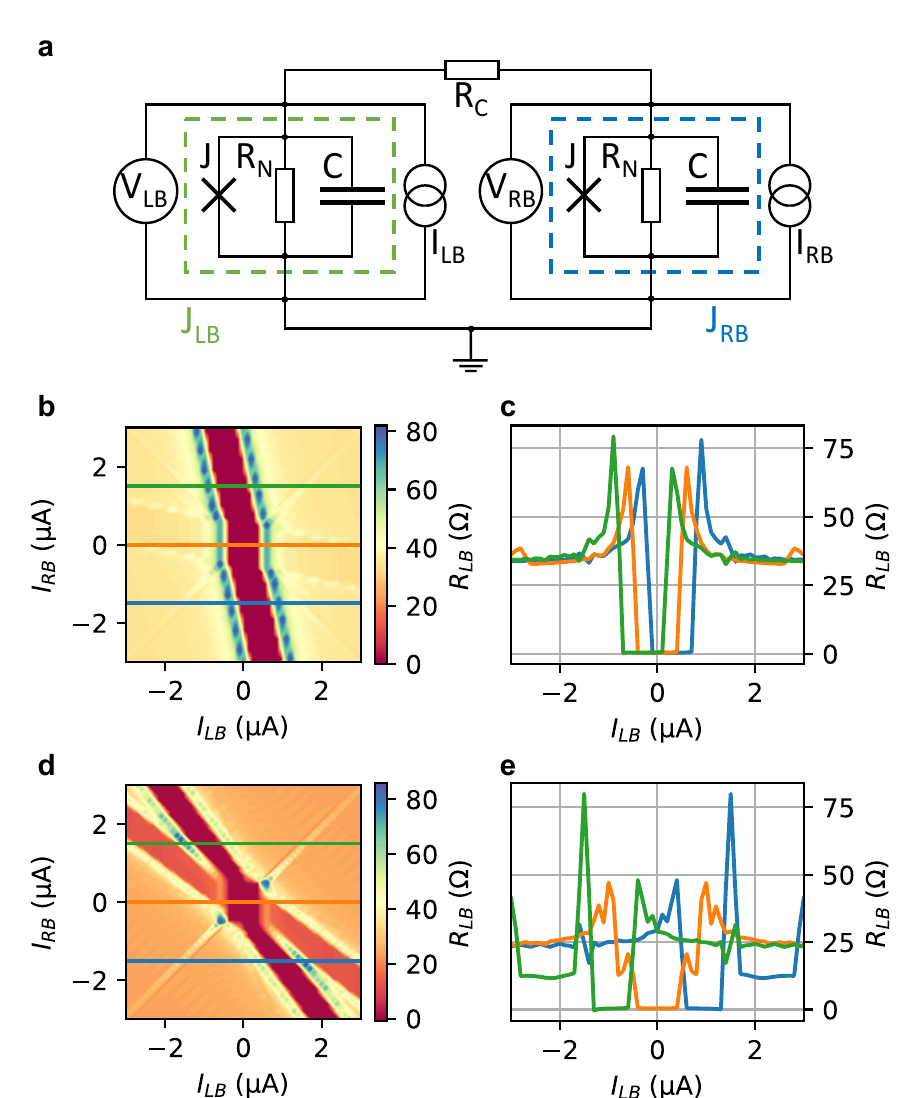
Figure 3. Numerical simulation of different coupling scenarios: ( a ) The three-terminal circuit is modeled by two resistively and capacitively shunted Josephson junctions J LB and J RB (green and blue dashed line boxes), which are each modeled by a resistor R N , a capacitor C and an ideal Josephson junction J . Currents I LB and I RB are supplied via current sources, while the voltage drops V LB and V RB across the junctions are measured. Both junctions are coupled via a coupling resistance R C . ( b ) Differential resistance R LB as a function of current biases for a realistic scenario for R C close to the C = 0.1. The one extracted in the experiment: R N = 40 Ω , R C = 160 Ω , I c = 538nA, β c = ( 2 e /¯ h ) I c R 2 N zero resistance range is observed as a tilted line due to compensation by a part of I RB . Additionally, the influence of the second junction is observed as a similar line close to horizontal orientation. The corresponding line cuts indicated in ( b ) are presented in ( c ). The scenario for a very small coupling resistance ( R C → 0) is shown as a color map of R LB and selected line cuts in ( d , e ). The model describes the experiment well by reproducing the Josephson supercurrent along the inclined lines originating from compensating currents from both electrodes with a superconducting region at the center. The inclination is determined by the coupling resistance R C . In Figure 3b,c, the coupling resistance was taken as R C = 4 · R LB , with R LB = 40 Ω which results in the same tilt as observed experimentally. Taking these values into account, the normal state resistance is given by R N = 6/5 · R LB = 48 Ω .